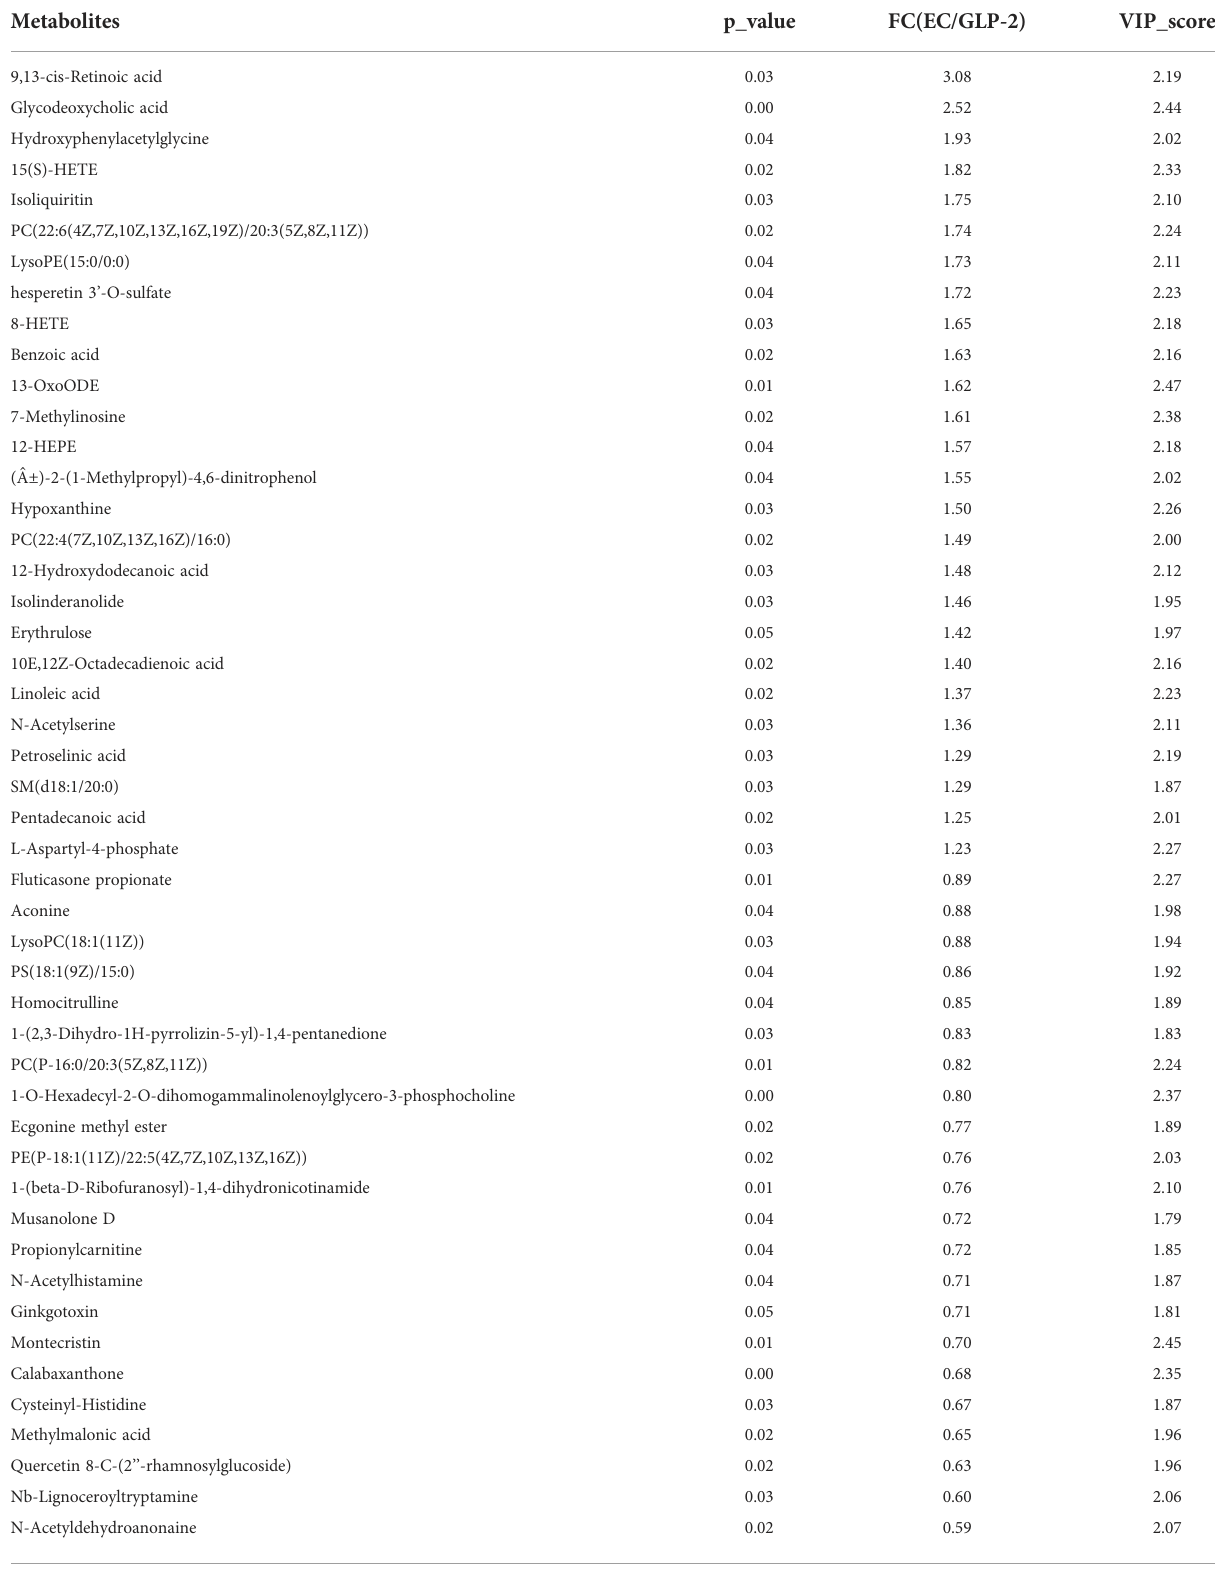
TABLE 3 28 upregulated and 26 downregulated metabolites in ethanol model (EC) vs. glucagon-like peptide-2 (GLP-2) rats.